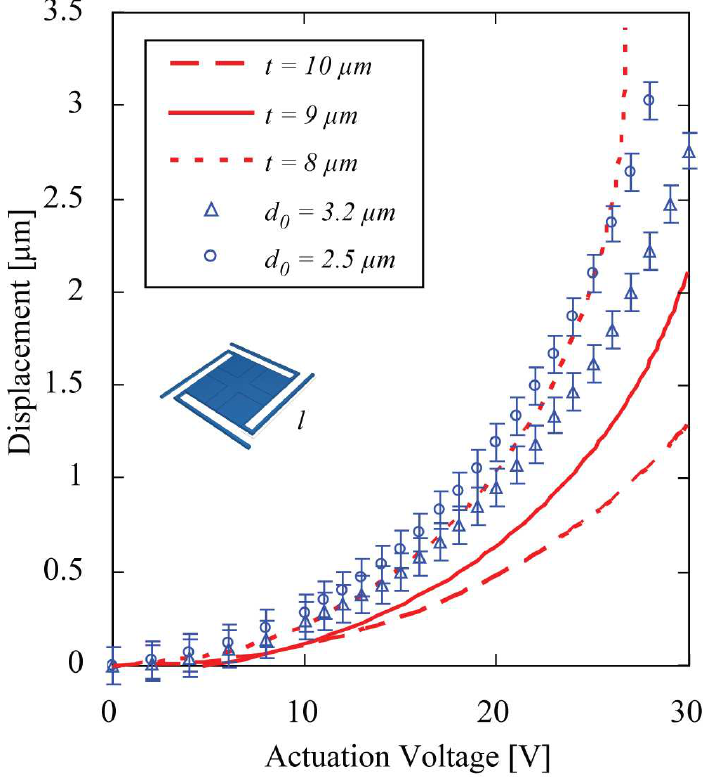
Figure 4: Finite Element simulations (lines) and measurements for different gold coated devices (data points) of the mirror displacement vs. applied voltage on the electrostatic actuators. Mirror square length is l = 400 µ m and thickness about t = 9 µ m. The differences are due to variations in thickness and different initial displacements d